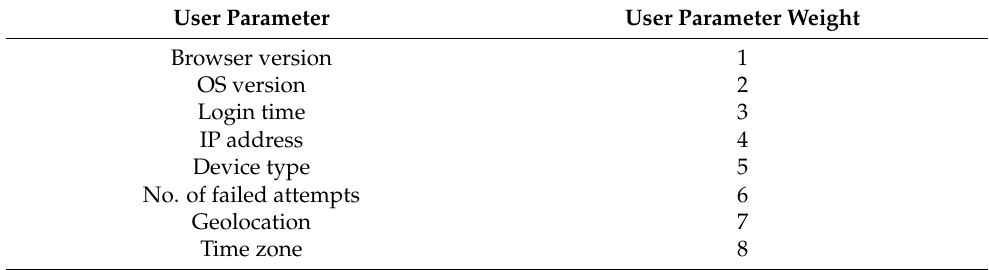
Table 1. User parameter weights [49].